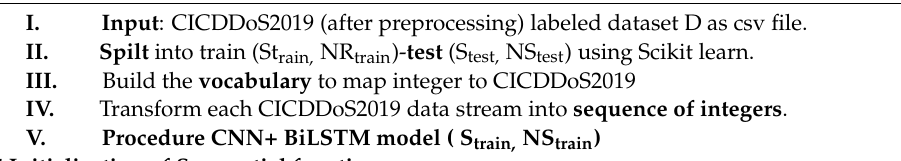
Algorithm 1. Pseudocode of the proposed DDoS attack prediction model.